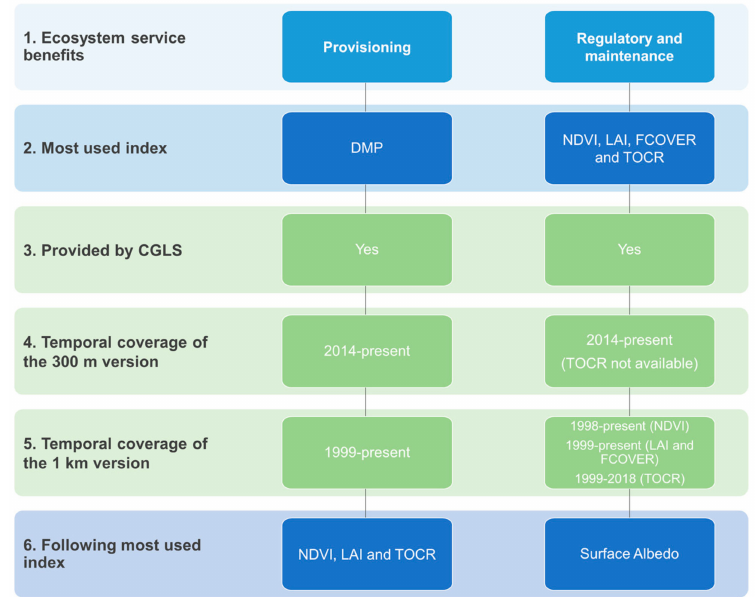
Figure A9. Decision flowchart indicating the most suitable indices available in the Copernicus Global Land Service for the monitoring of ecosystem services provided by NWRMs.